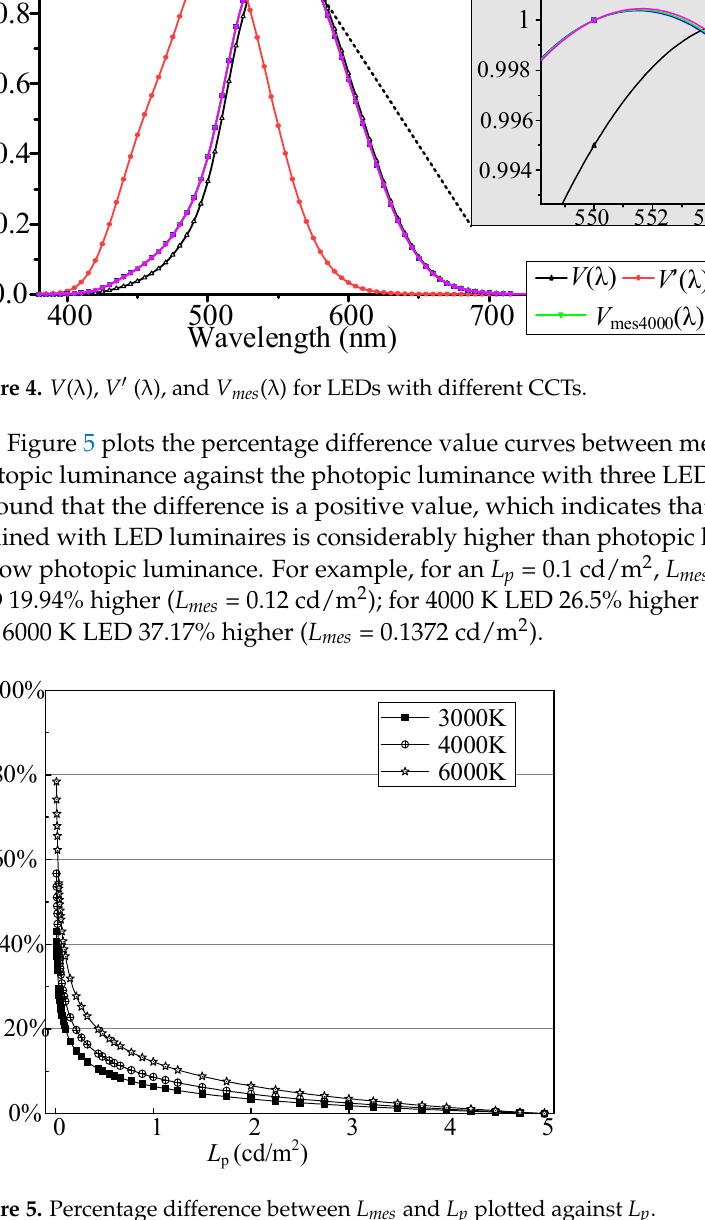
mes and L p plotted against L p